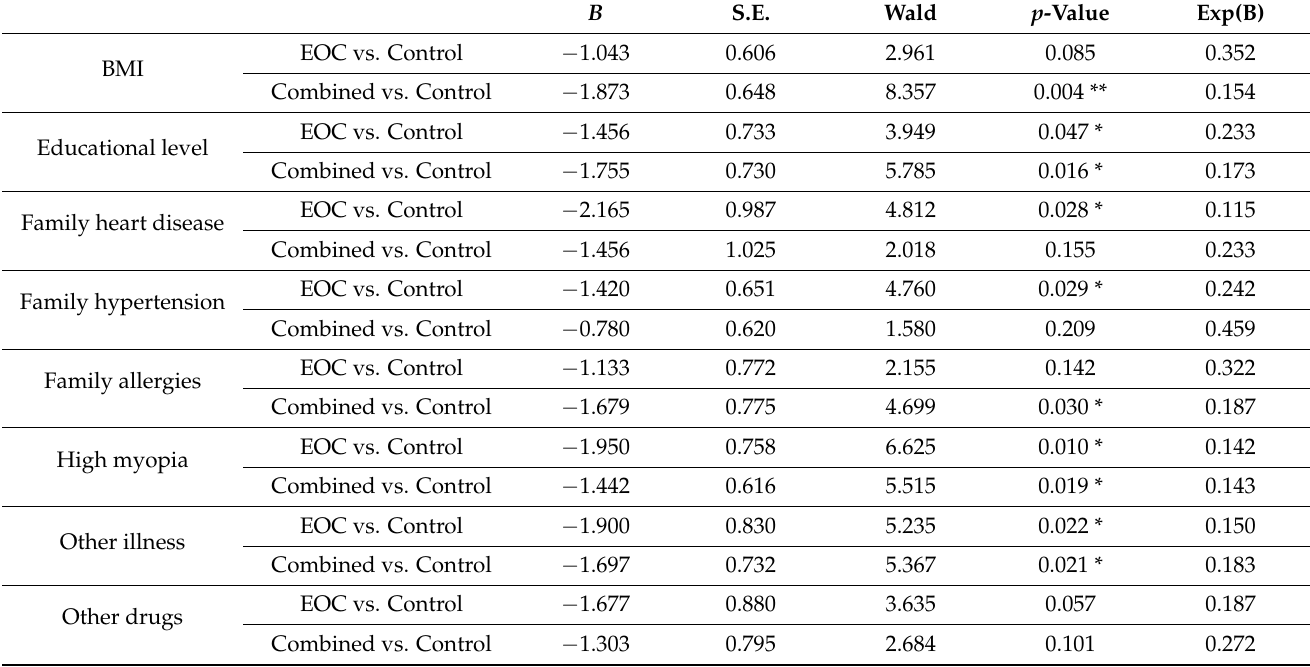
Table 6. Multinomial logistic regression analysis between each